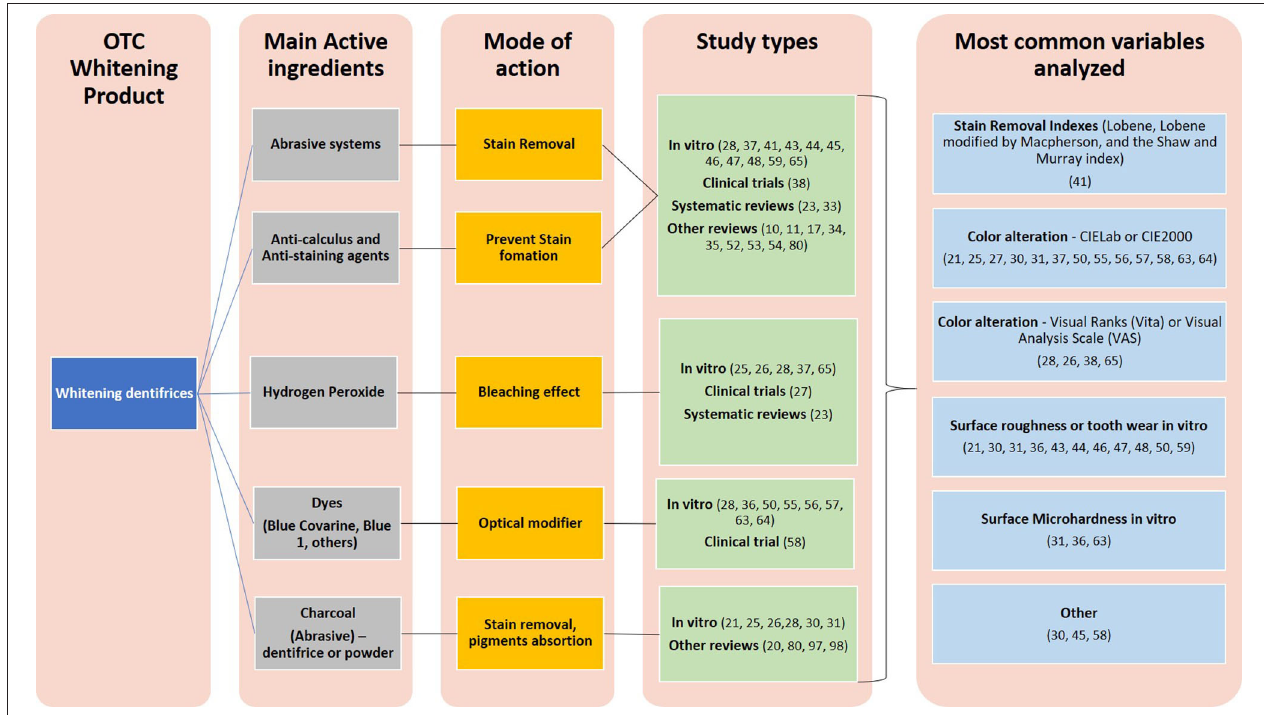
FIGURE 1 | Main findings from the evaluated studies considering whitening dentifrices as